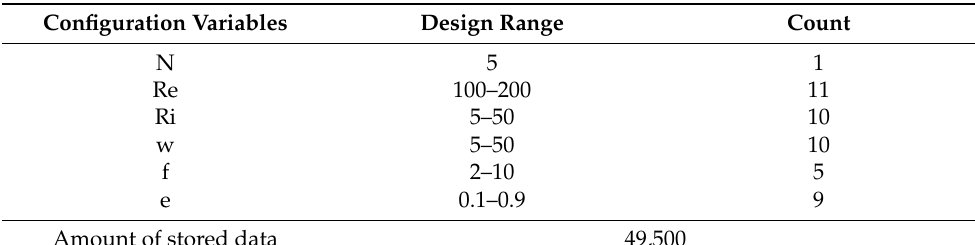
Table 3. Database construction